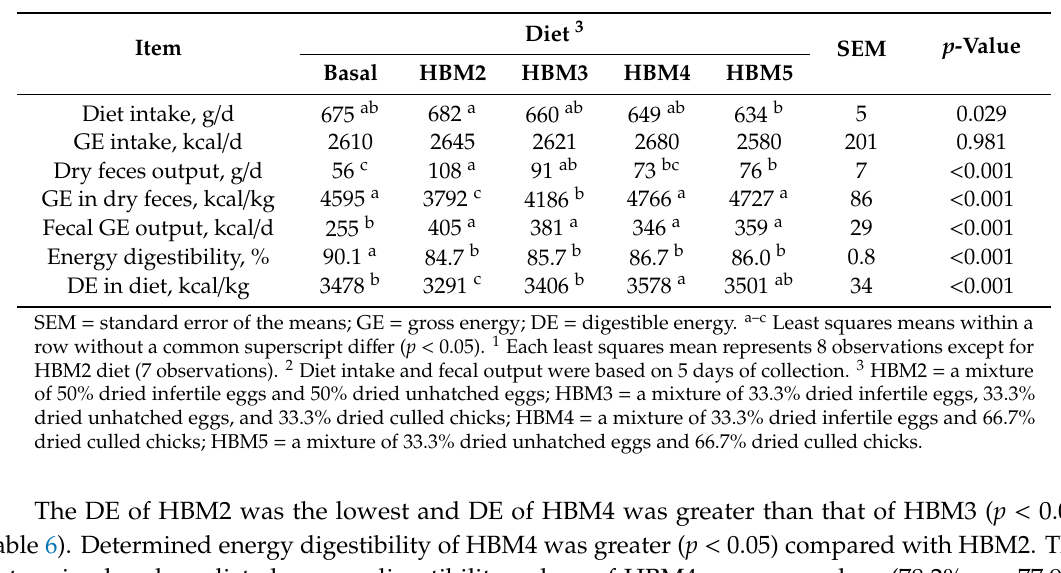
Table 5. Energy digestibility of pigs fed experimental diets, as-fed basis 1,2 .